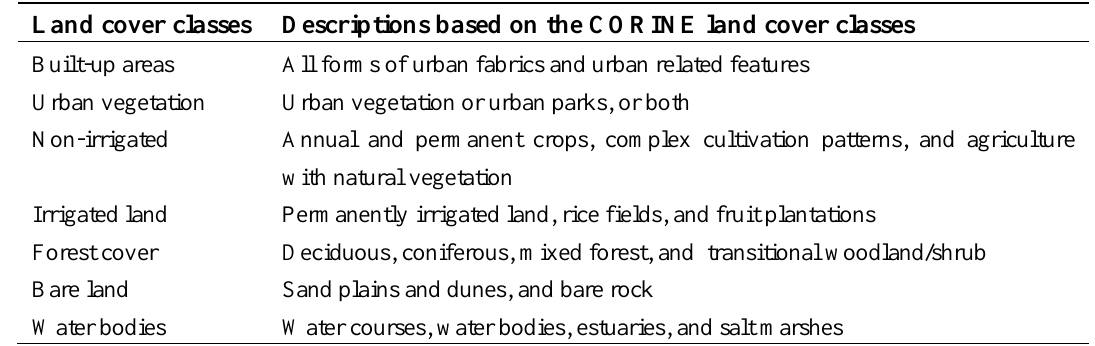
Table 1. Land cover classes used in the